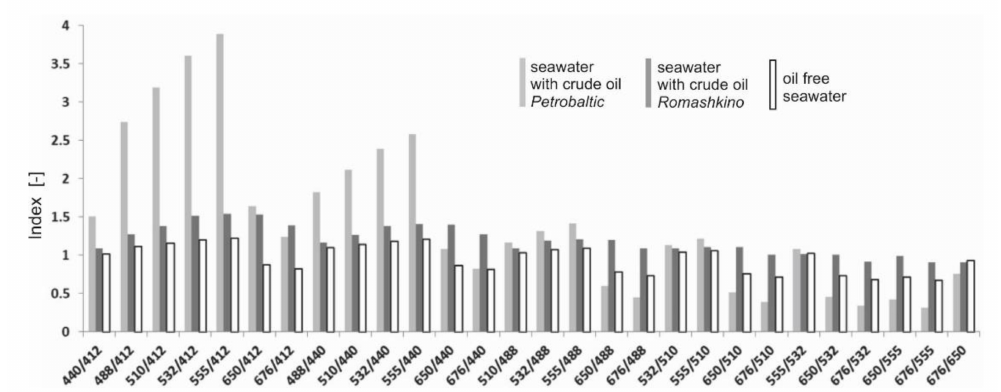
Figure 3. Spectral indices of the sea free from oil and in conditions of dispersed oil contamination for a wind-induced rough sea surface (2 m/s).